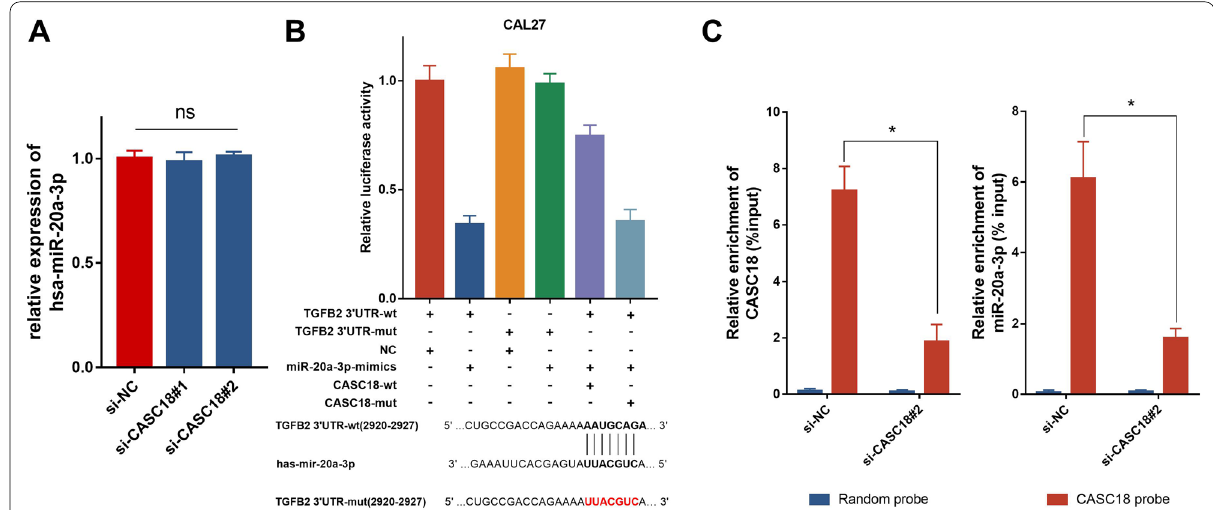
Fig. 6 CASC18 positively regulates TGFB2 by acting as the miR-20a-3p sponge A The impact of CASC18 knockdown on the expressions of miR-20a-3p in CAL27 by qRT-PCR. B Luciferase activity in CAL27 cells co-transfected with siRNAs and miRNA inhibitors. C RNA pulldown assay was executed in CAL27 cells, followed by qRT-PCR to detect the enrichment of CASC18 and miR-20a-3p. Data are presented as the mean SD. *p < ±